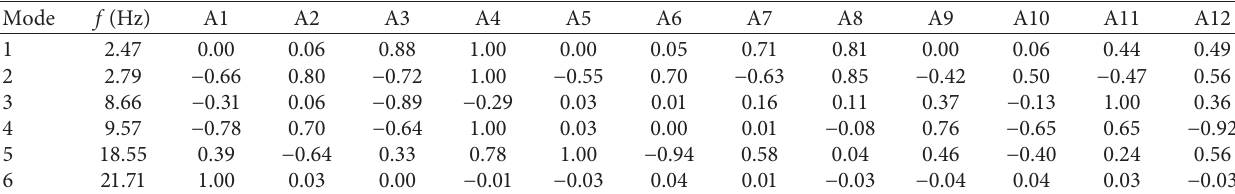
Table 2: Natural vibration modes identified by dynamic tests with the vibration generator in Position #2. Mode